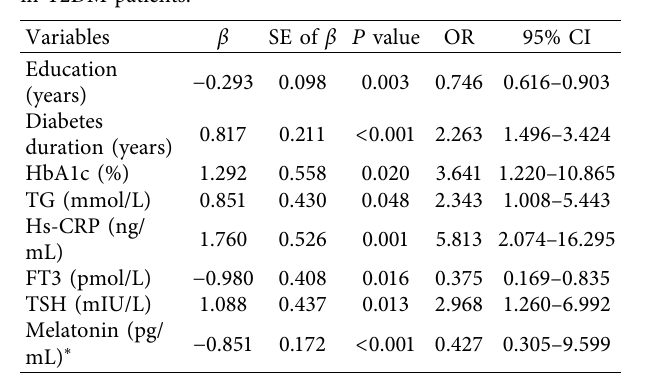
Figure 2: Correlation of serum melatonin to thyroid hormone in diabetic patients. Serum melatonin levels are positively correlated with (a) FT3 ( r � 0.170, P � 0.008) and (b) FT4 ( r � 0.172, P � 0.007) and are negatively correlated with (c) TSH ( r � − 0.137, P � 0.032). Spearman’s rank correlation test was performed. Table 4: Logistic multivariate regression evaluates the risk of MCI in T2DM patients.